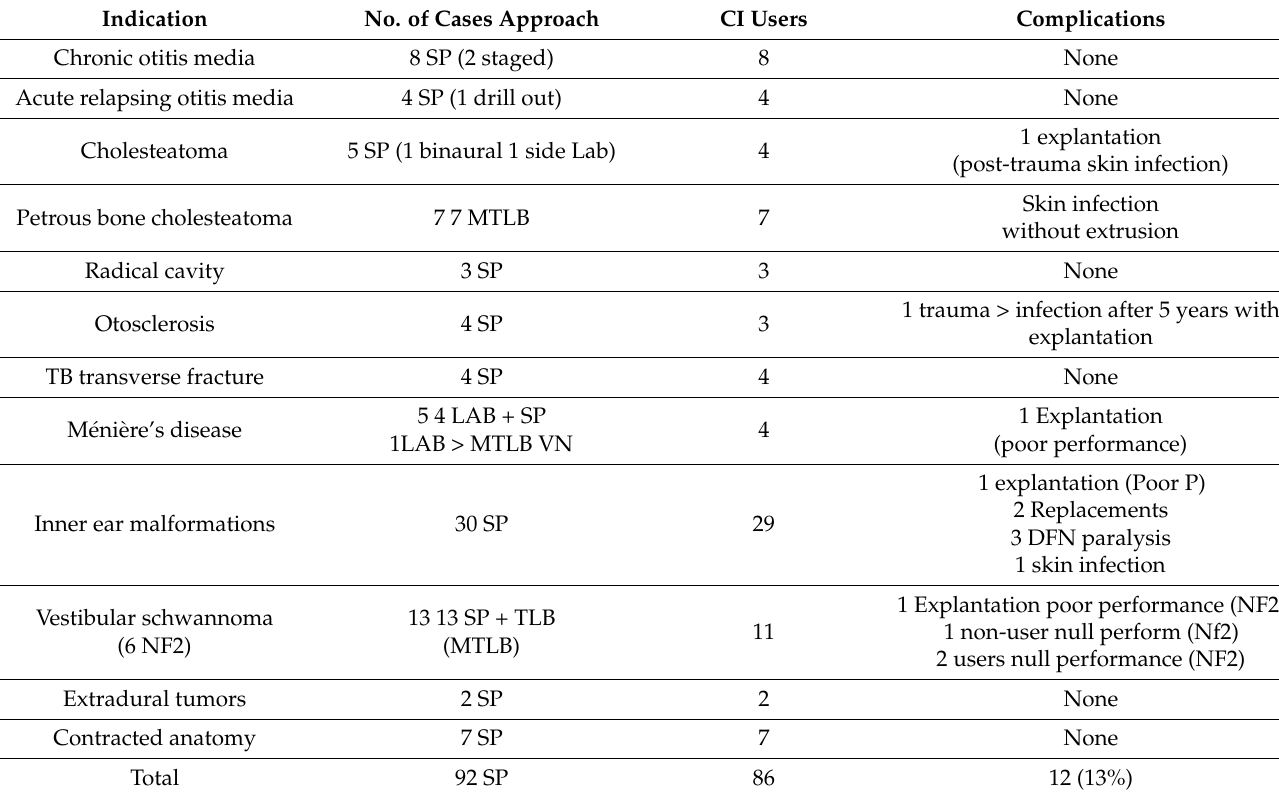
Table 1. Distribution of patients by indication. SP, subtotal petrosectomy; MTLB, modified translabyrinthine approach; LAB, labyrinthectomy; DFN, delayed facial